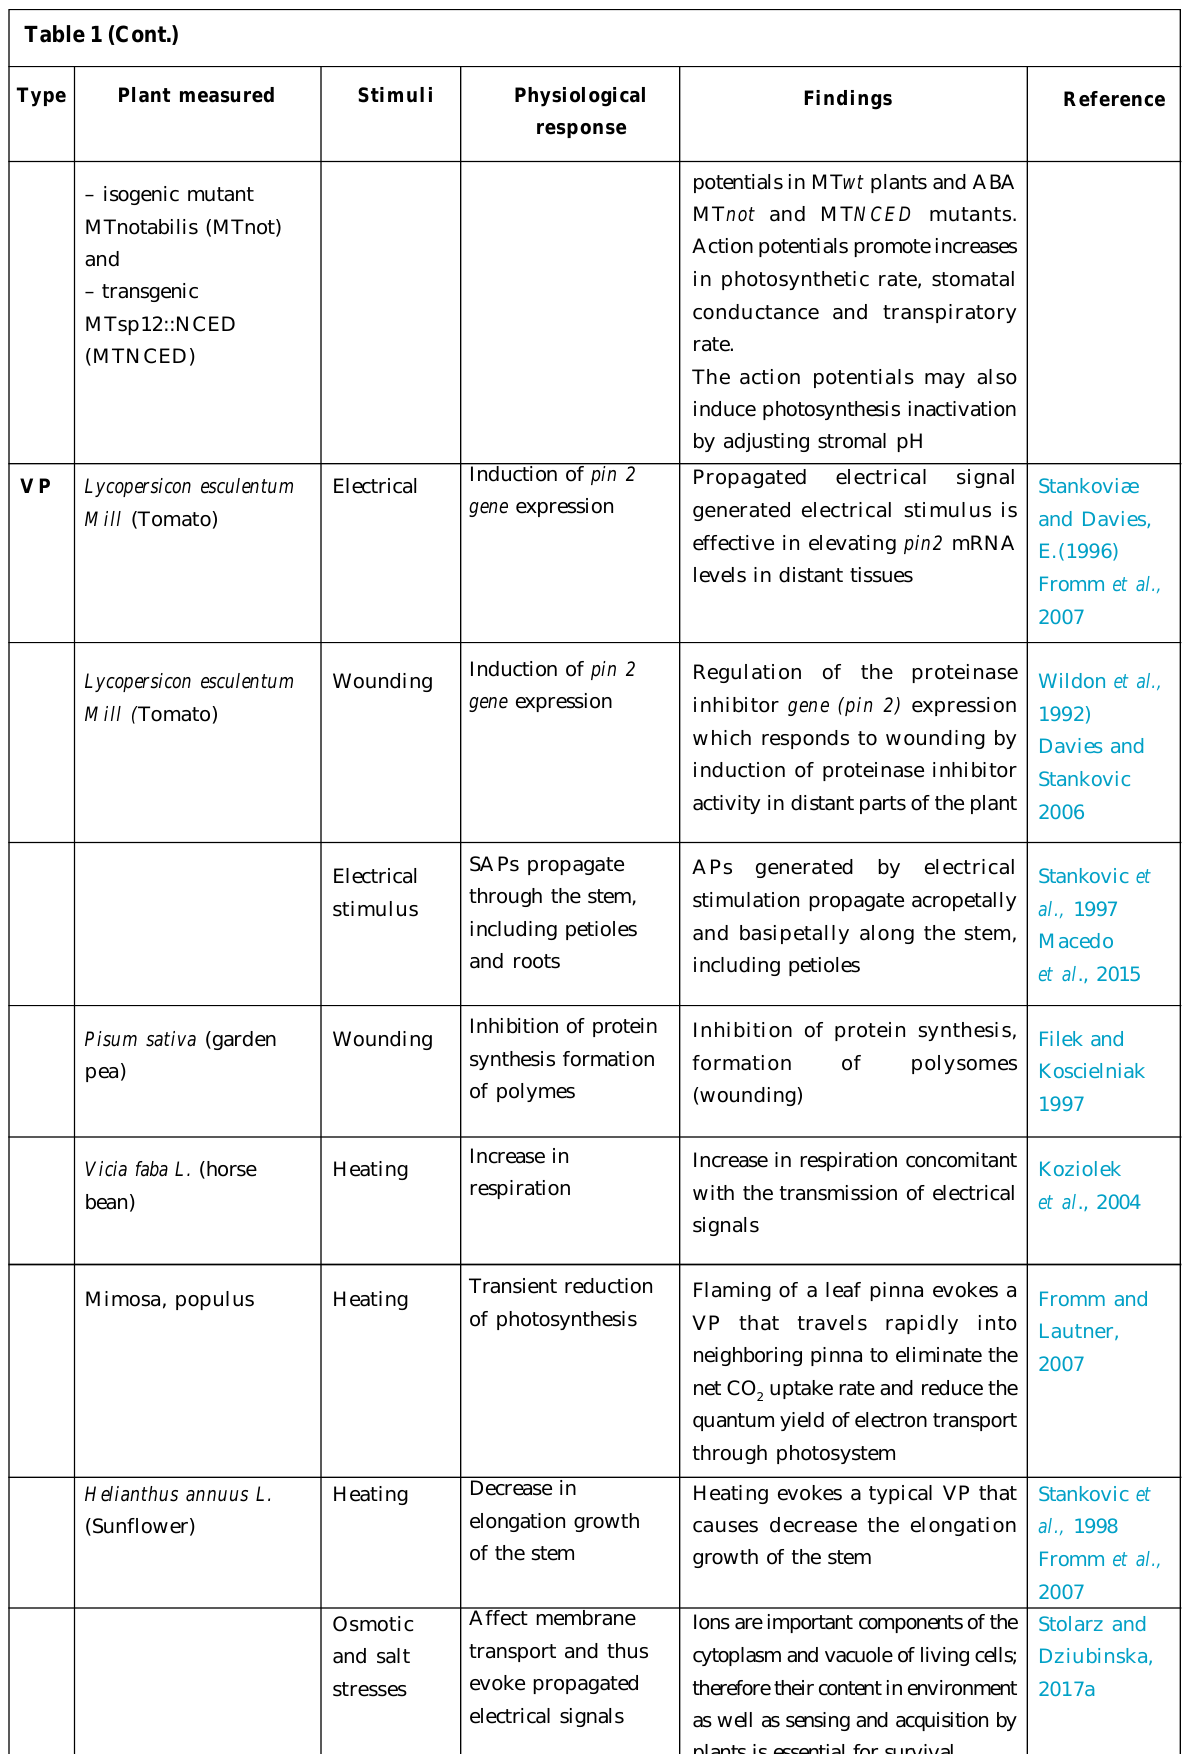
Table 1 (Cont.) Plant measured Stimuli